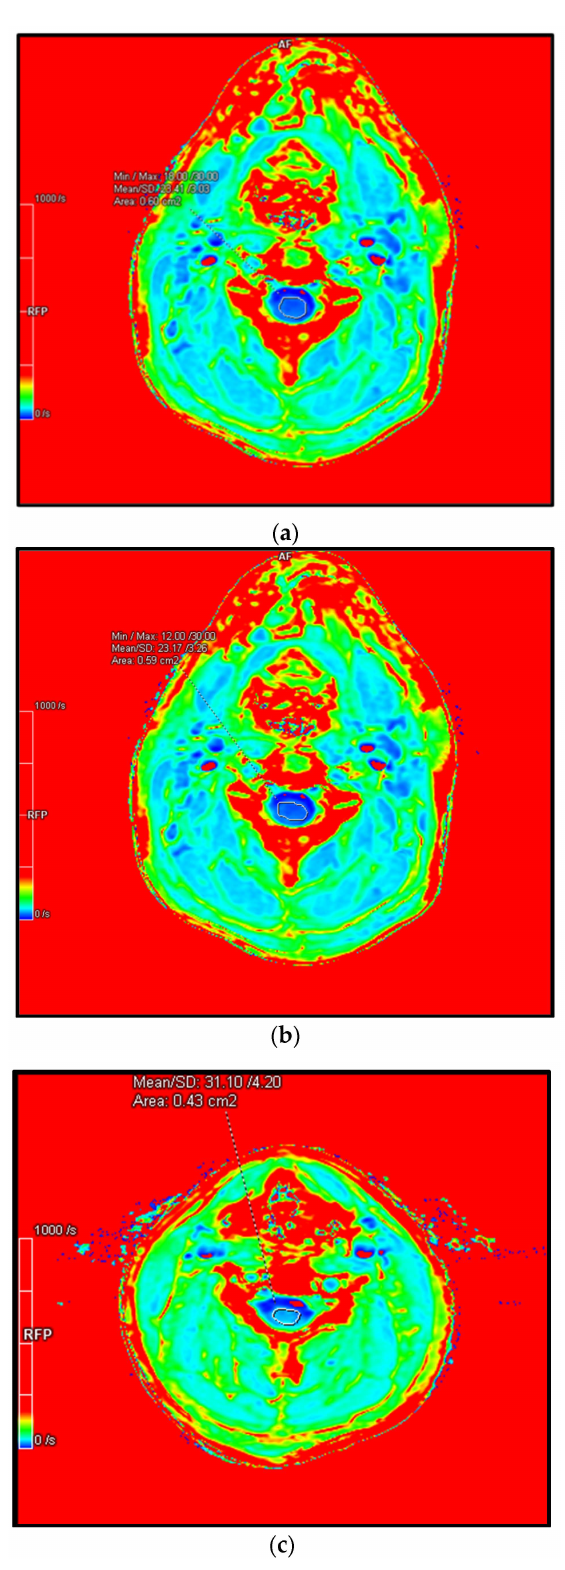
Figure 5. Preliminary data obtained from a healthy recruit using 3T MAGNETOM PRISMA MRI scanner with R2* MRI. ( a ) axial R2* map of C2/3 cervical spinal-cord. ( b ) axial R2* map of C4/5 cer- vical spinal-cord. ( c ) axial R2* map of C2/3 cervical spinal-cord. Abbreviations: DCM, degenerative cervical myelopathy; MRI, magnetic resonance imaging; ROI, region of